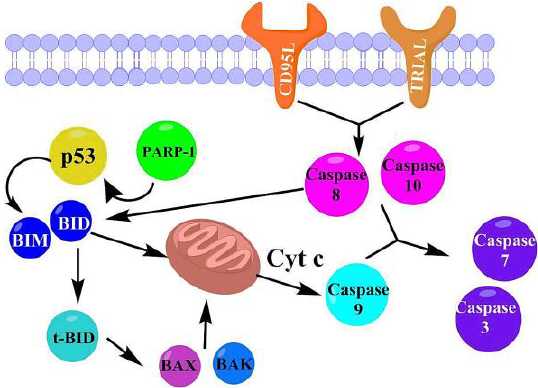
Figure 8. Intrinsic and extrinsic pathways of apoptosis.